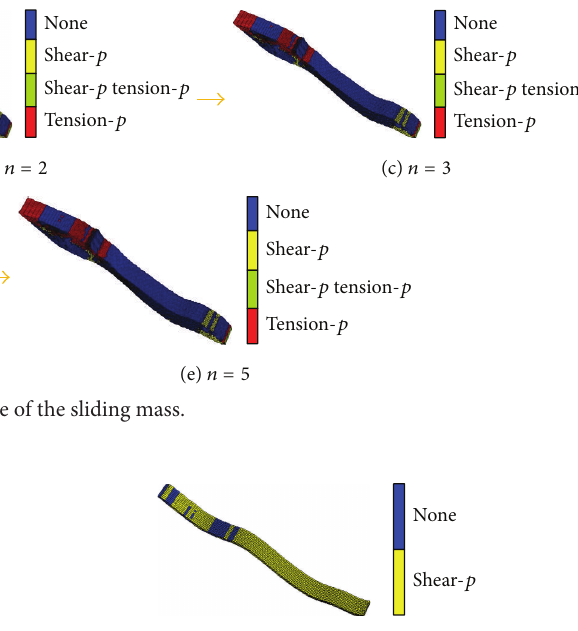
Figure 14: Plastic state of the main sliding zone after five earth-